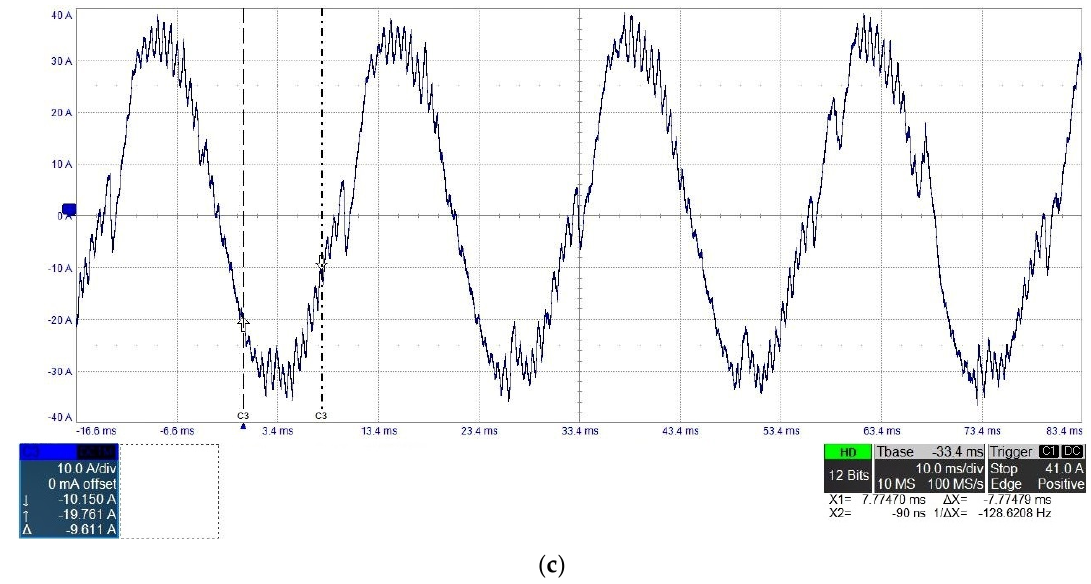
Figure 13. Measured current waveforms of developed FI-PMa-SynRM with the current of 32.5 A and angle of − 55 degrees: ( a ) Phase U; ( b ) Phase V; ( c ) Phase W.